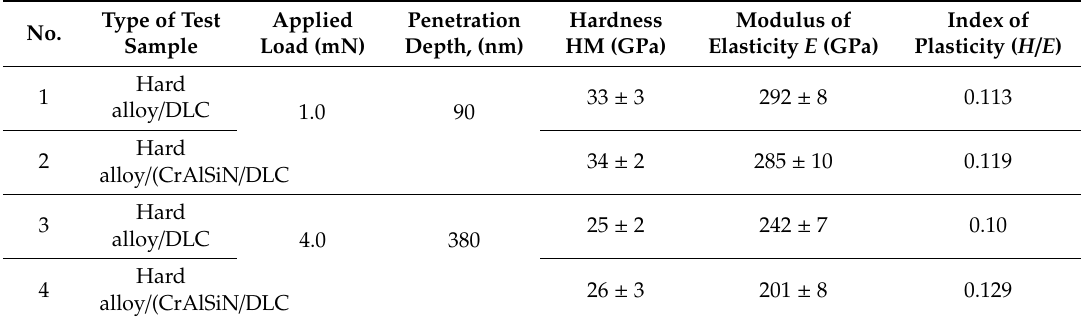
Table 6. Physical and mechanical characteristics of DLCs deposited on hard alloy